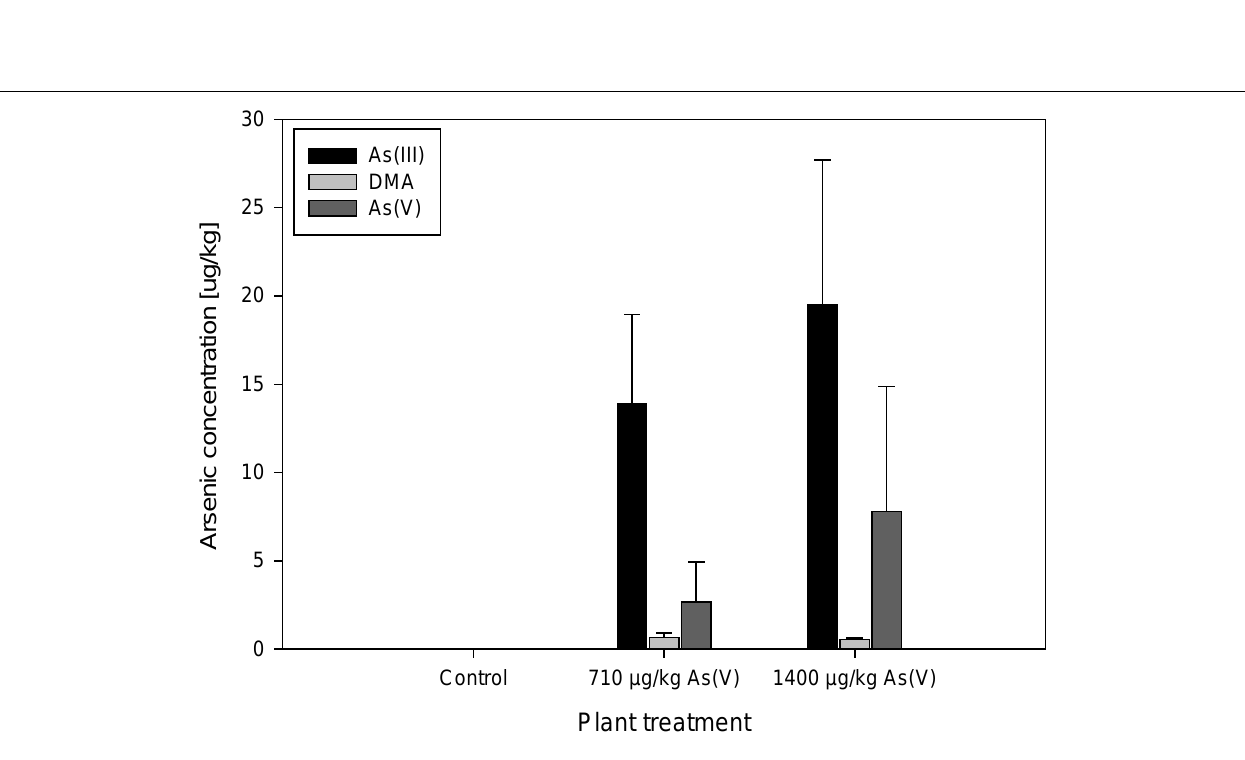
FIGUREA17 |Arsenic concentration and speciation in xylem sap of plants grown for 28 ± 3days (plant setA) and challenged with no arsenic and As(V) at 710 and 1400 μ g/kg for 24h. Sap extracted for 1h. Concentration of blank xylem sap was below LOD of 0.5 μ g/kg (3 σ of noise; n = 12).